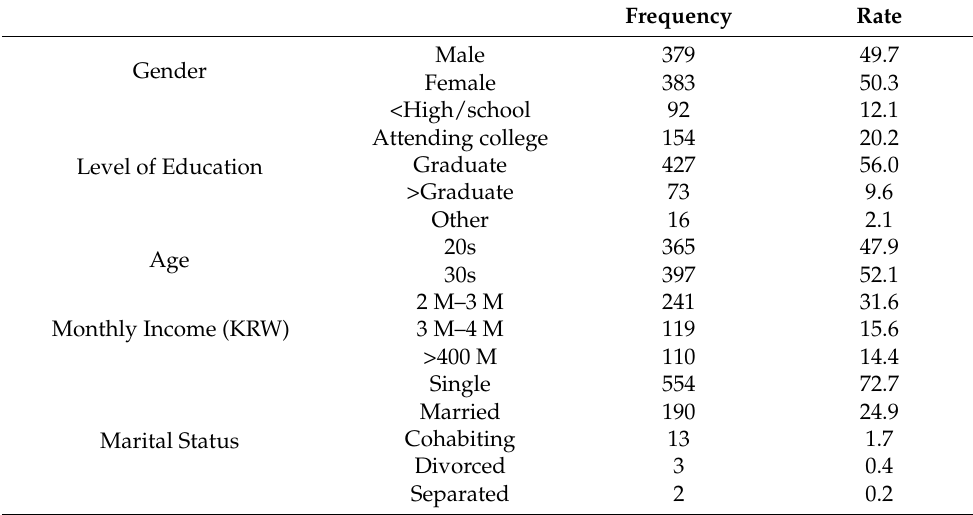
Table 1. Demographic and sociological characteristics of subjects (N =